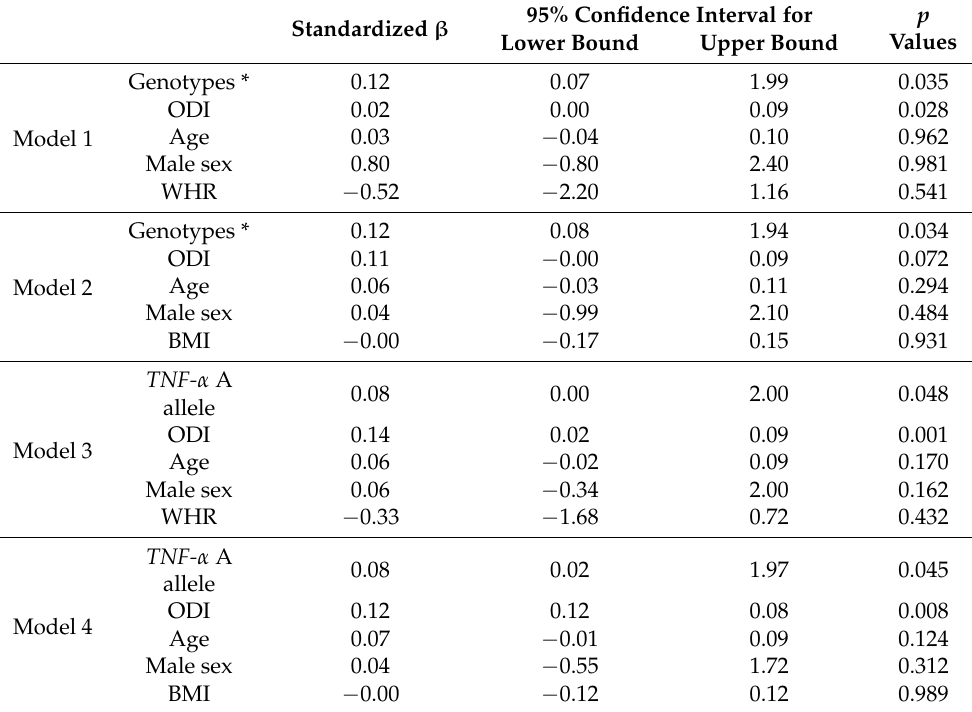
Table 4. Multivariate analysis of the variables associated with circulating TNF- α levels.